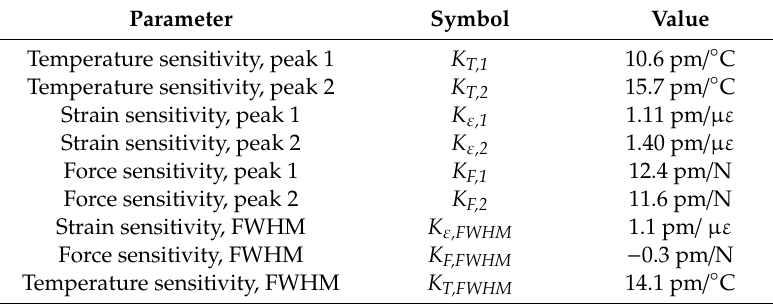
Table 2. Sensitivities of peaks 1 and 2 for temperature, strain and